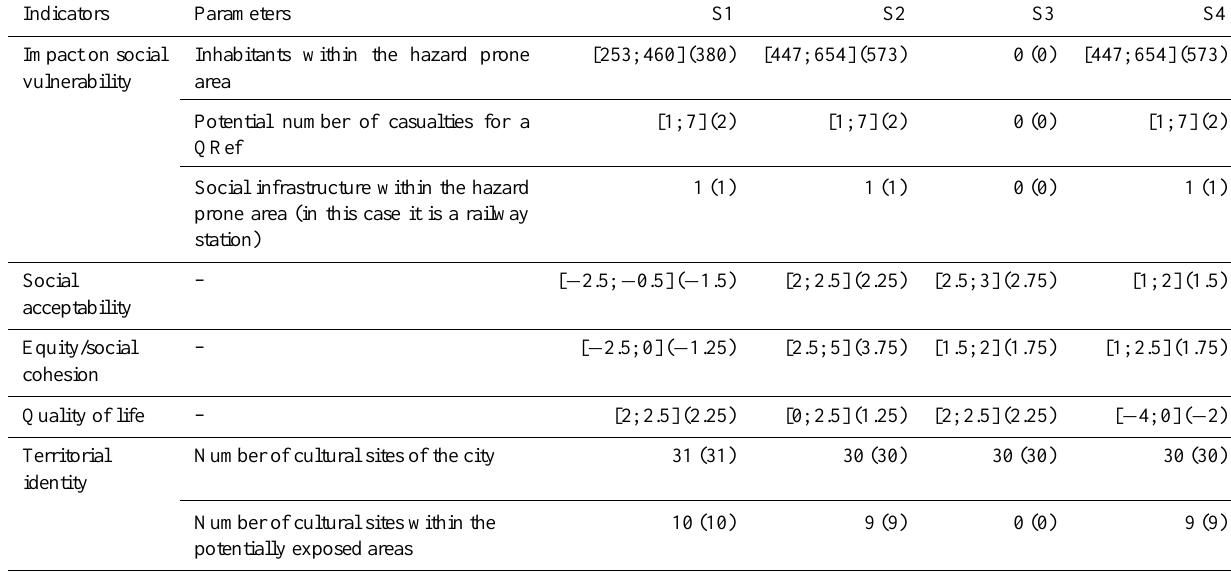
Table 5. Extract of the “social sustainability” criterion input data from the worksheet. Indicators Parameters Impact on social vulnerability